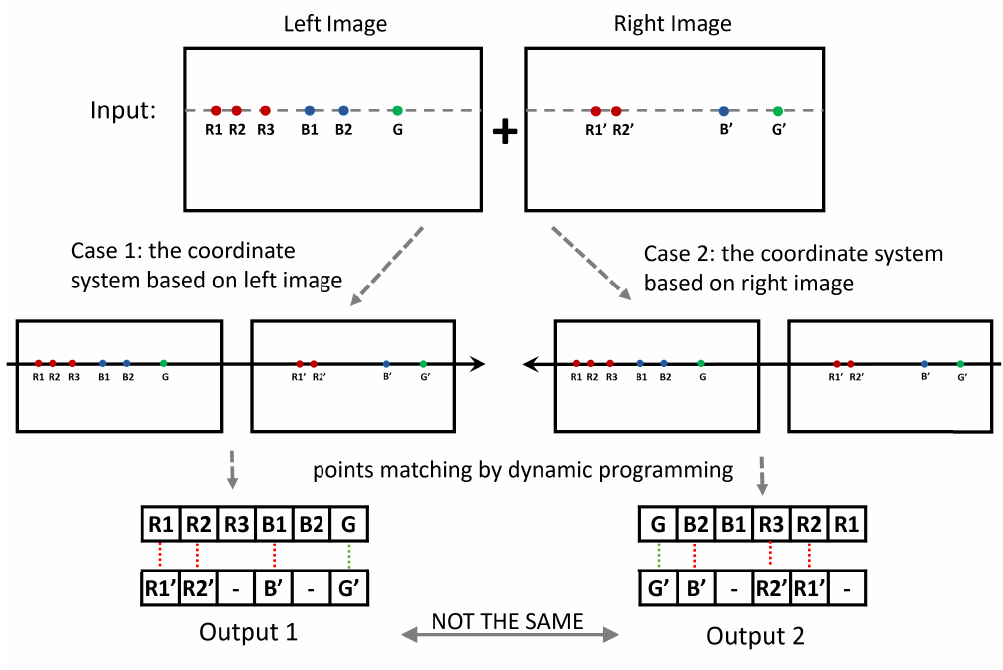
Figure 4. Example of different matching orders. For the same sequences to be matched, the results will be different if the coordinate systems are not the same. The red dotted lines in the results indicate inconsistent pairs on both